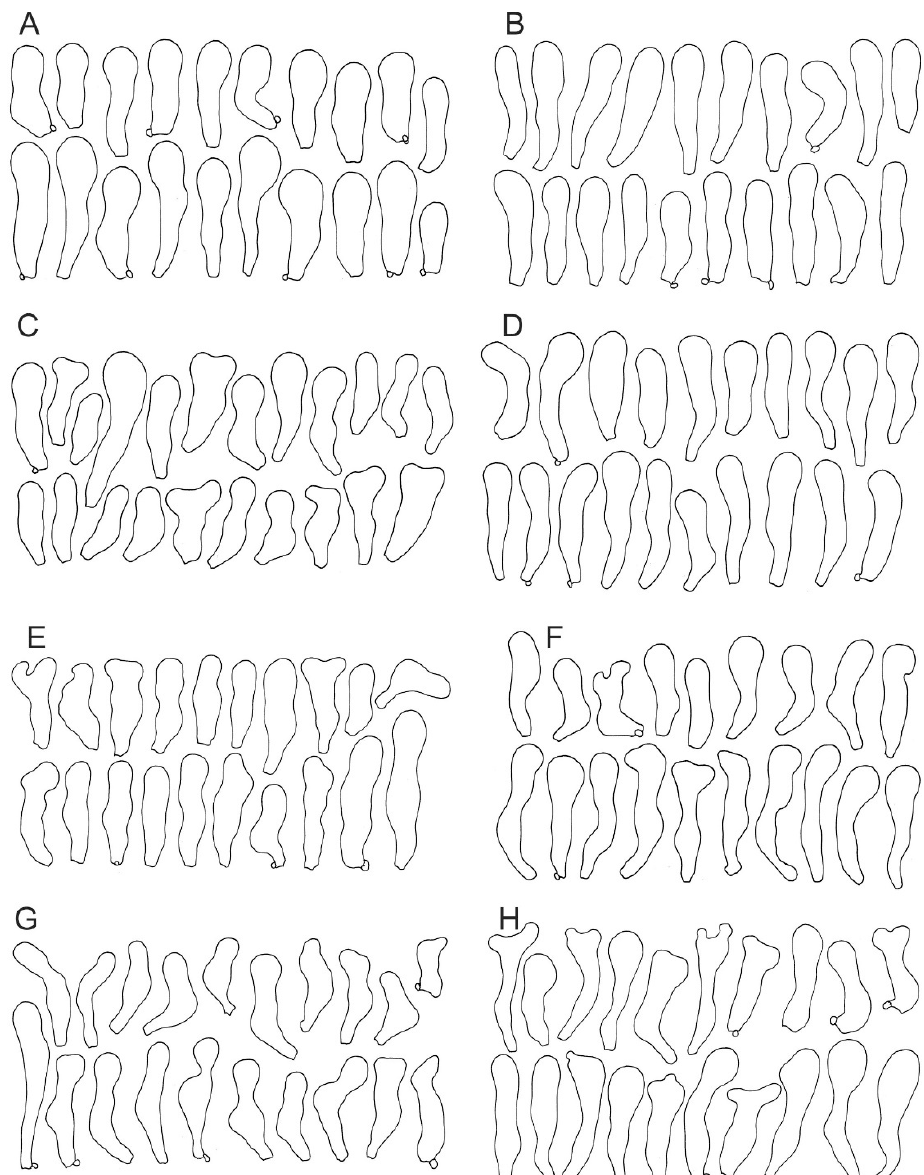
Figure 4. Cheilocystidia variability of Crepidotus applanatus . ( A ) SLO 1821, ( B ) SLO 2528, ( C ) SLO 1492, ( D ) SLO 2547, ( E ) SLO 2533, ( F ) SLO 2534, ( G ) SLO 2539, ( H ) SLO 2537. Scale bar = 10 × µ m. Ecology: Most of our collections of C. applanatus were from the wood of fallen trunks, fewer were from fallen branches, and one collection was from a standing trunk. The most common host tree was Fagus sylvatica , and less common was Acer pseudoplatanus , Quercus sp., and Salix sp.; that it grew on Picea abies is questionable. The fallen trunks and branches were usually 20 to 40 cm thick, in full contact with the soil and basidiomata grew mainly on their lateral side; basidiomata on a standing trunk grew to a height of about 150 cm. The substrates of the 3rd to 5th decay stages were often overgrown with mosses. The findings were from the months of July, September, and October. Most of our collections were from old-growth forests protected as nature reserves in Slovakia, few collections were from managed forests. Of the habitats, the species was most common in beech and fir-beech forests ( Fagus sylvatica dominates the tree layer, along with admixed Abies alba , Acer pseudoplatanus , Picea abies, and others); one collection was from oak-hornbeam woods (tree layer is predominantly occupied by Carpinus betulus , Quercus petraea, and Q. robur ); another one was from a former pasture having gradually been covered with wood trees